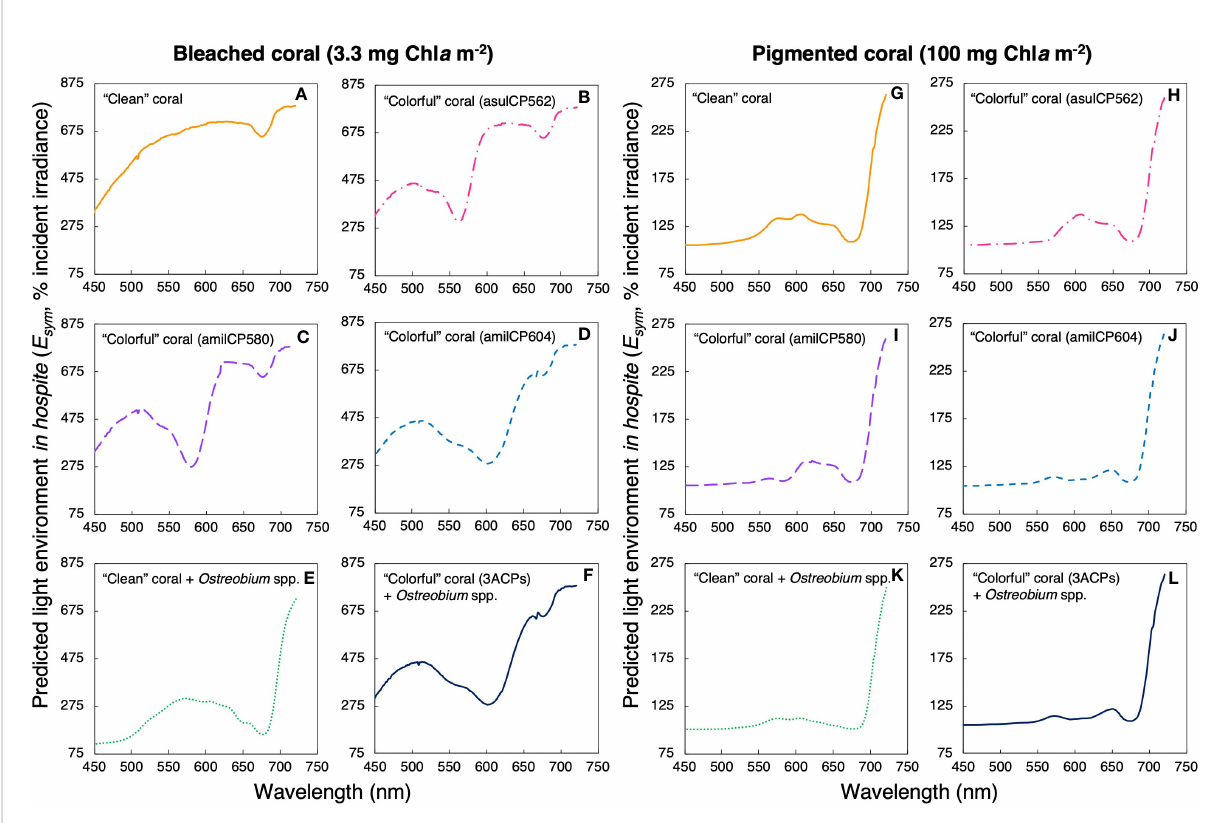
FIGURE 5 Predicted light environment in hospite for a bleached coral ( A-F , 3.3 mg Chl a m -2 ) and a pigmented coral ( G-L , 100 mg Chl a m -2 ) under different scenarios: a coral with a white skeleton (yellow solid line, A, G ), a coral with the chromoprotein asulCP562 upregulated in its tissue (pink dotted line, B, H ), a coral with the chromoprotein amilCP580 upregulated in its tissue (purple dashed line, C, I ), a coral with the chromoprotein amilCP604 upregulated in its tissue (clear blue dotted line, D, J ), a coral with an Ostreobium bloom in the skeletal surface (green dotted line, E, K ), and, a coral with the three chromoproteins upregulated in its tissue and an Ostreobium bloom in the skeletal surface (navy blue solid line, F, L